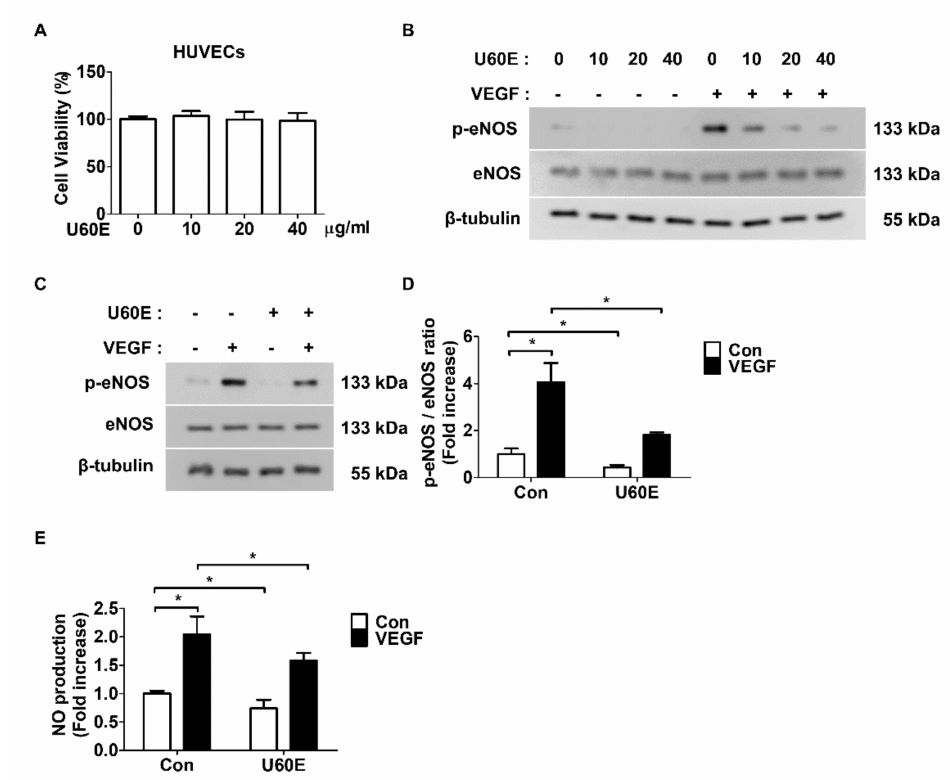
Figure 1. Effect of U. davidiana (U60E) on endothelial nitric oxide synthase (eNOS) activation and Nitric oxide (NO) production in Human Umbilical Vein Endothelial Cells (HUVECs). ( A ) HUVECs were treated with U60E for 24 h at indicated doses. The cell viability was determined by the MTT assay. The bar graph represents the means ± SD ( n = 4). ( B ) HUVECs were treated with Vascular endothelial growth factor (VEGF) (20 ng/mL) and/or U60E (indicated doses) for 30 min. The phosphorylation of eNOS (p-eNOS) was determined by Western blot analysis. eNOS and β -tubulin were used as controls. ( C ) HUVECs were treated with VEGF (20 ng/mL) and/or U60E (20 µ g/mL). The phosphorylation of eNOS (p-eNOS) was determined by Western blot analysis. ( D ) Quantitative densitometric analysis of Western blots in ( C ). The bar graph represents the means ± SD ( n = 3). ( E ) HUVECs were treated with VEGF (20 ng/mL) and/or U60E (20 µ g/mL) for 24 h. Nitric oxide (NO) production was determined by Griess assay. Values are represented as the mean of fold increase ± SD ( n = 4). * p <